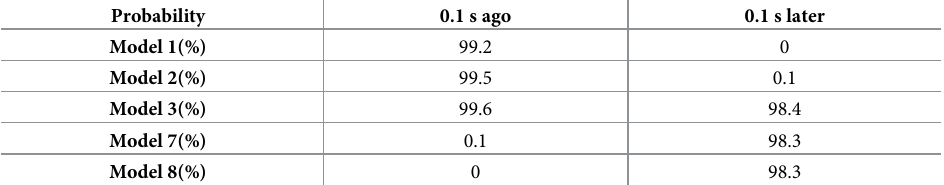
Table 9. Comparison of probability of matching models under simulation of simultaneous occurrence of multiple faults.